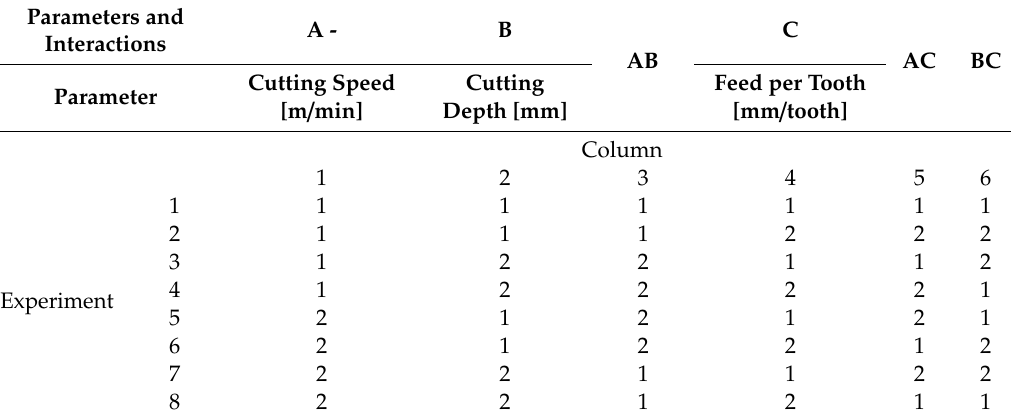
Table 6. The 8 experiments according to L8 (2 7 ) orthogonal